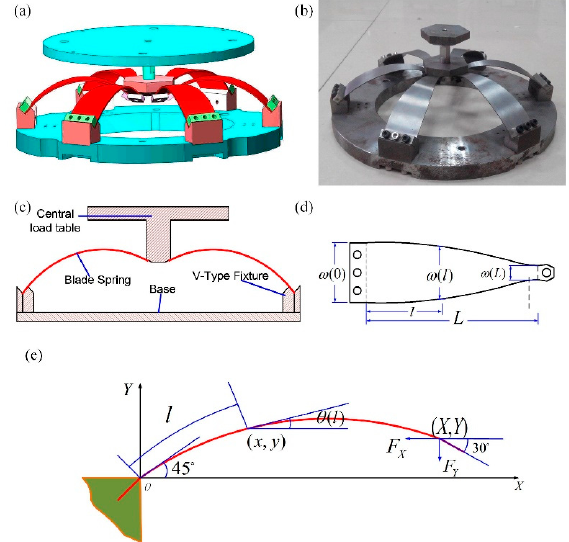
Figure 1. The model of the geometric anti-spring isolator. ( a ) Schematic of the geometric anti-spring isolator. ( b ) Photograph of the geometric anti-spring isolator. ( c ) Cross-section diagrams of the geometric anti-spring isolator. ( d ) The shape of the cantilever blade spring. ( e ) One dimension mechanical model of the blade spring.